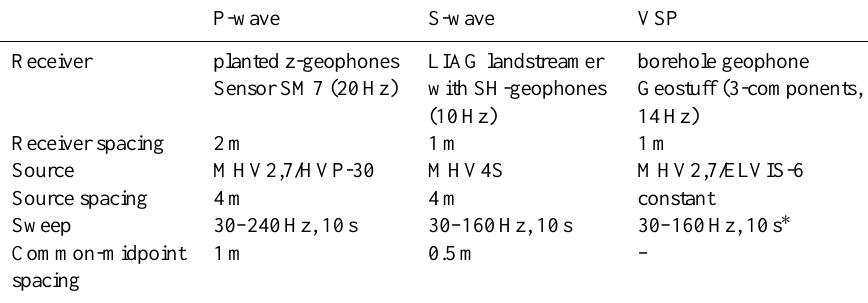
Table 1. Acquisition parameter for seismic